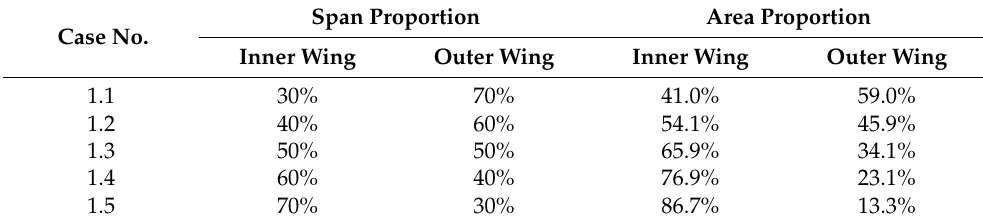
Table 3. List of cases for analysis of the effect of inner/outer wing proportion. Span Proportion Area Proportion Case No. Inner Wing Outer Wing Inner Wing Outer Wing 1.1 30% 70% 41.0%